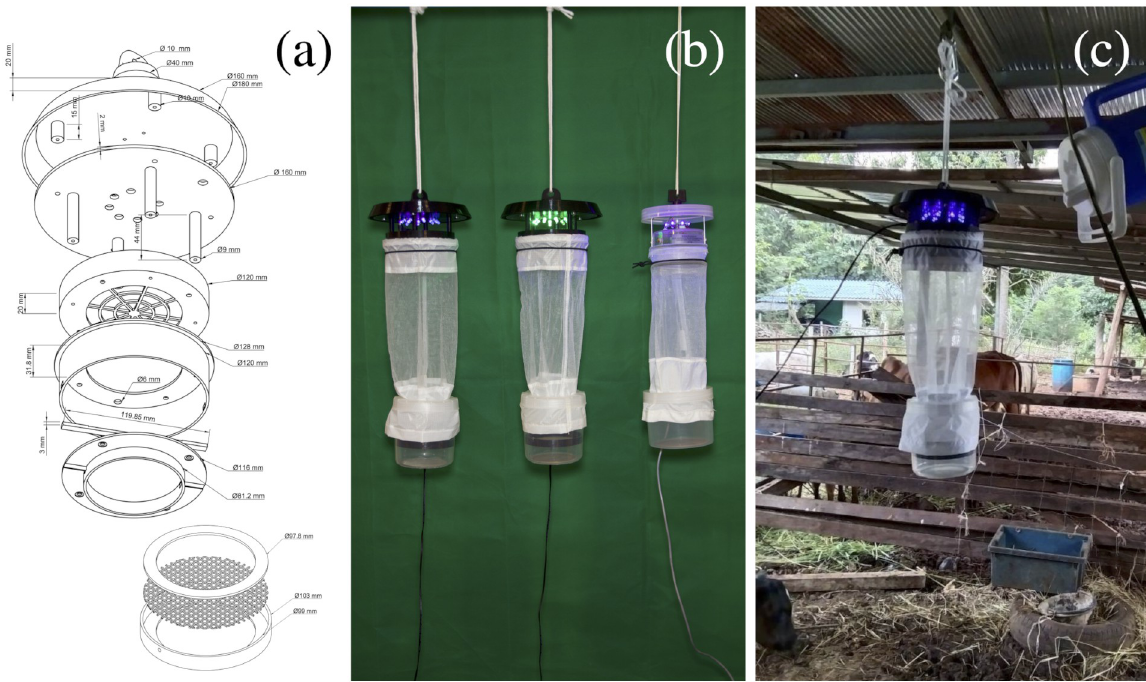
Fig 1. Light traps evaluated for the collection of Culicoides . (a) Newly designed 3D-printed LED light trap blueprint and a custom-designed Culicoides sorting-out frame (bottom); (b) trap size comparisons (left to right: MU UV LED, MU Green LED, and BioQuip 2770); and (c) MU UV LED light trap in field operation.